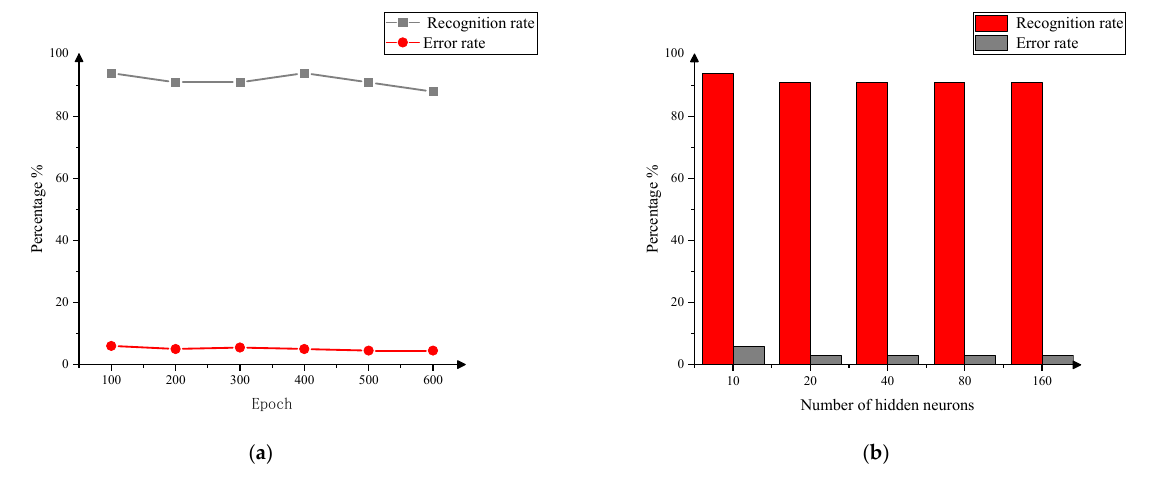
Figure 6. The effect of epoch and number of hidden neurons on fraud identification. ( a ) The effect of epoch on recognition rate; ( b ) The effect of number of hidden neurons on recognition rate. The variation range of the recognition rate is small, which is relatively stable at around 90.9%. With the increase of the operation steps, the recognition rate changes be ‐ tween 90.9–93.9%, and the recognition rate decreases to 87.87% at operation steps of 600. The error rate decreases gradually with the increase of the operation step, indicating that, with the increase of the operation step, the recognition rate is still accurate. When the op ‐ eration steps are 500 and 600, the error rate is stable at 4.5%. The recognition rate and error rate of fraud events are obtained by using 10, 20, 40, 80, and 160 hidden neurons, respec ‐ tively, as shown in Figure 6b. With the increase in the number of hidden neurons, the recognition rate is relatively stable, maintained at 90.9%, and the error rate changes from 6% to 3%. Using neural networks to identify data can improve the identification rate to 90.9%, which is far greater than the fraud rate of 13.1%.